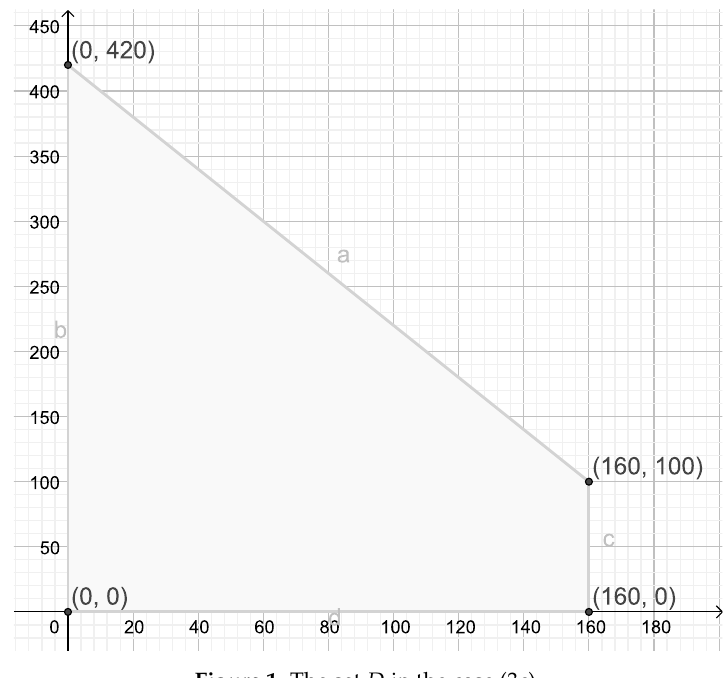
Figure 1. The set D in the case (3c). Table 1. Values of the iterated sequence ( x n , y n ) if started with ( 40,60 ) . n